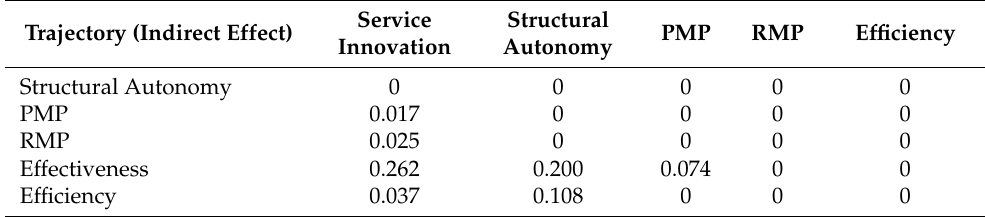
Table 2. Indirect effects of model